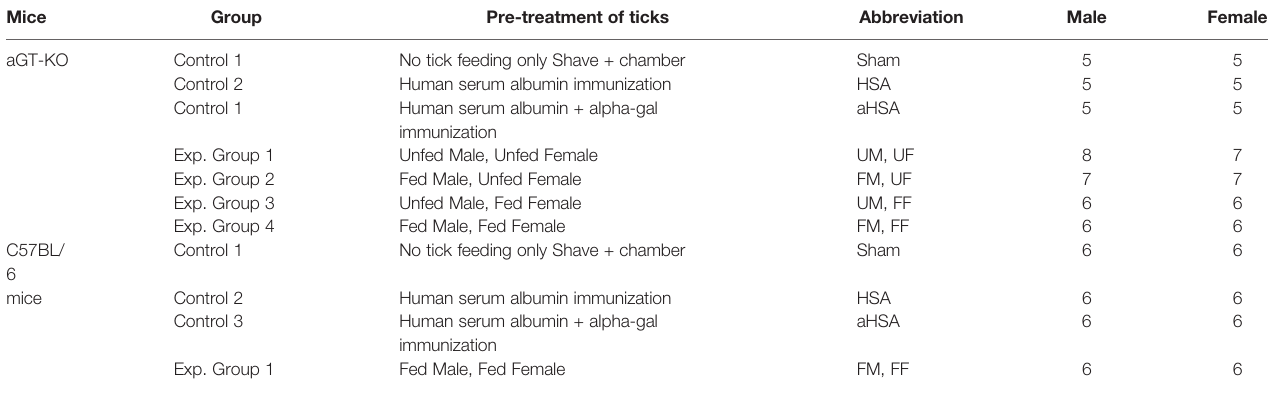
TABLE 1 | Experimental groups assigned to mice and tick pre-treatments for experiment 1. Mice Group Pre-treatment of